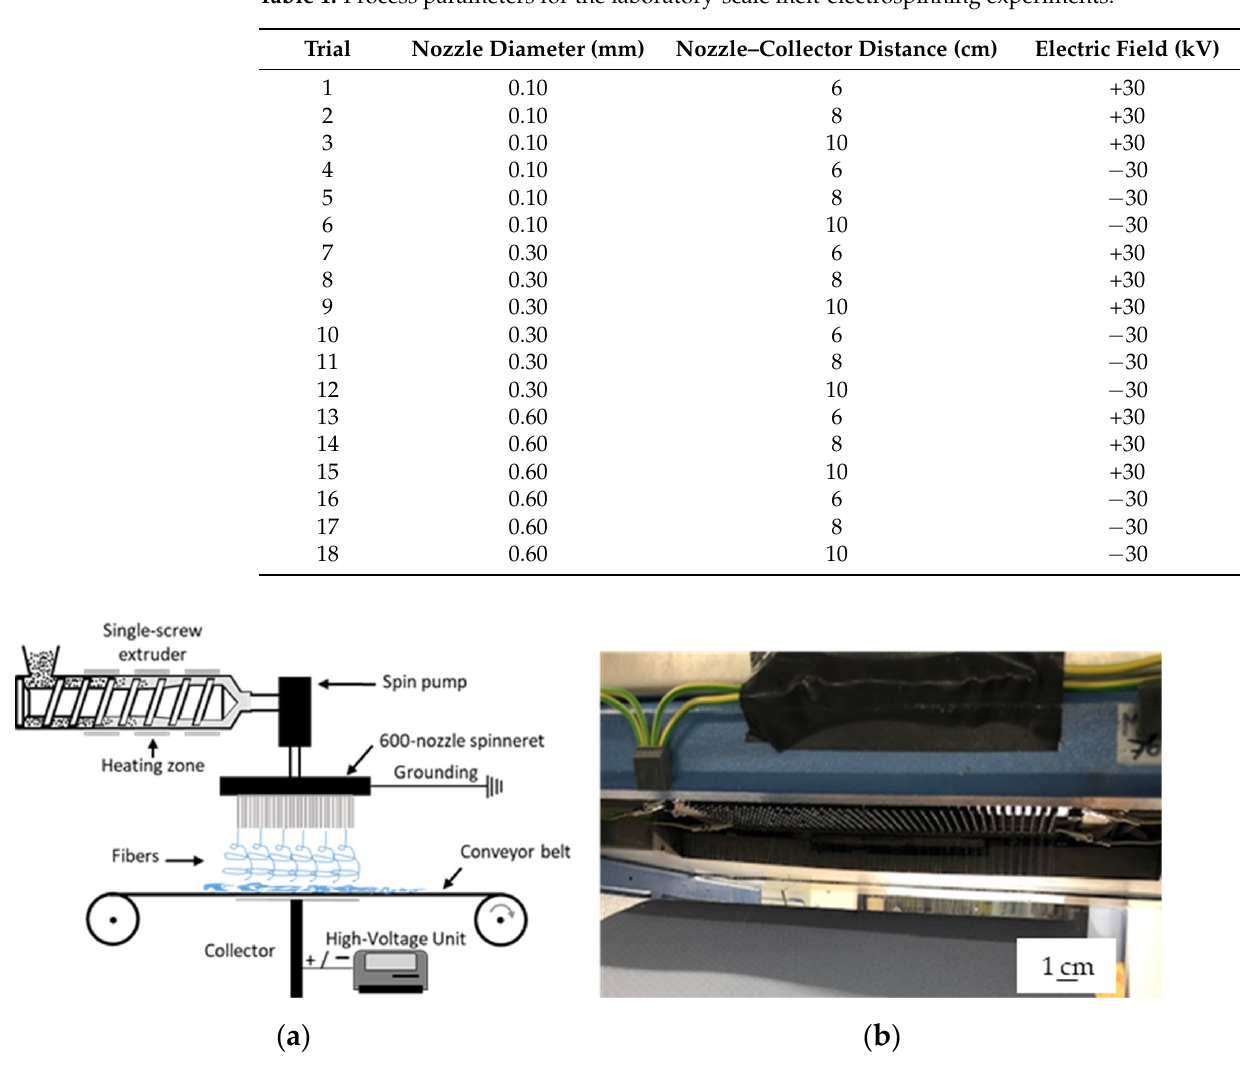
Figure 3. Our pilot-scale melt-electrospinning prototype. ( a ) Setup of the pilot-scale electrospinning machine. ( b ) Grounded spinneret including 600 nozzles. Table 2. Process parameters for the pilot-scale melt-electrospinning experiments. Trial